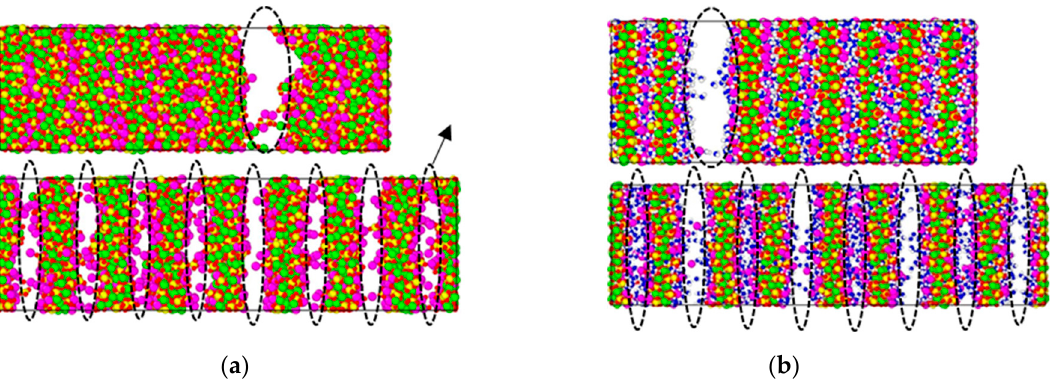
Figure 2. Under tensile loading with strain rate at 0.8 ps − 1 (below) and 0.0008 ps − 1 (above), the failure